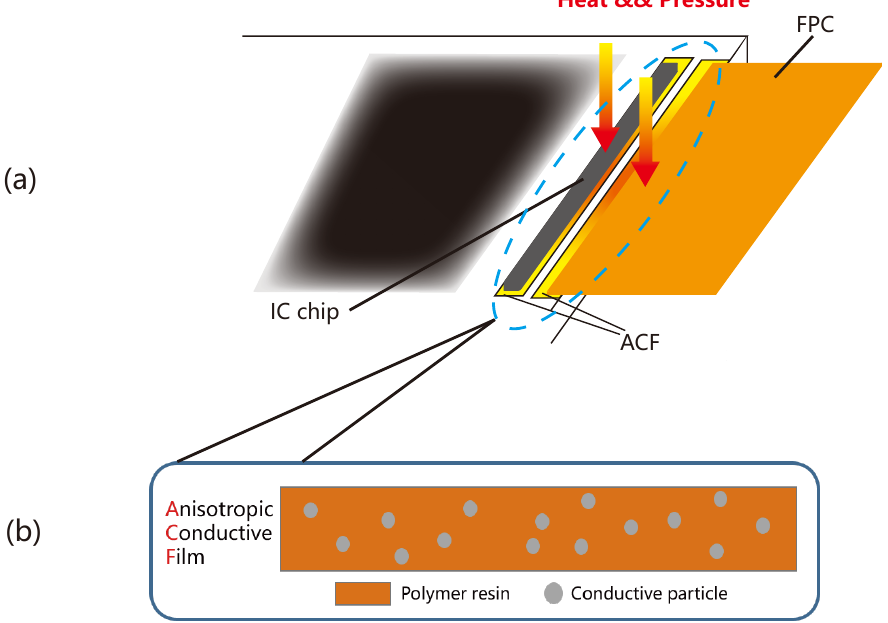
Figure 2. ( a ) Demonstrates the diagram of the bonding process; ( b ) is zoomed in to show the composition of the